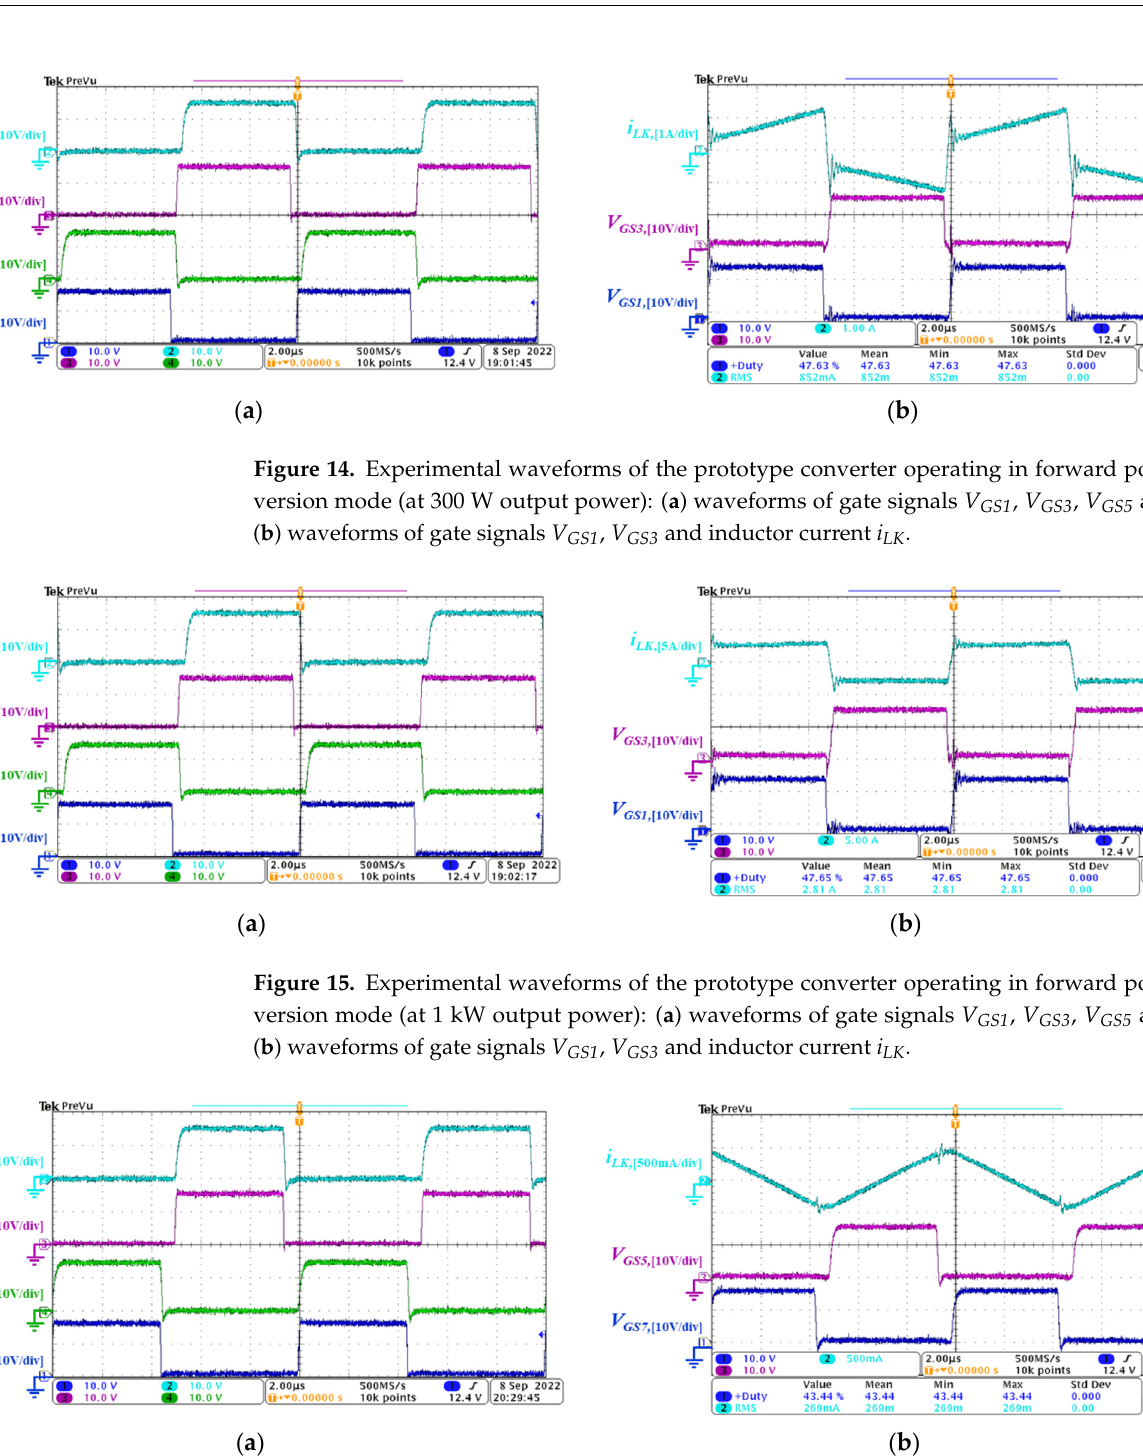
Figure 16. Experimental waveforms of the prototype converter operating in backward power con- version mode (at 10 W output power): ( a ) waveforms of gate signals V GS1 , V GS3 , V GS5 and V GS7 ; ( b ) waveforms of gate signals V GS5 , V GS7 and inductor current i LK